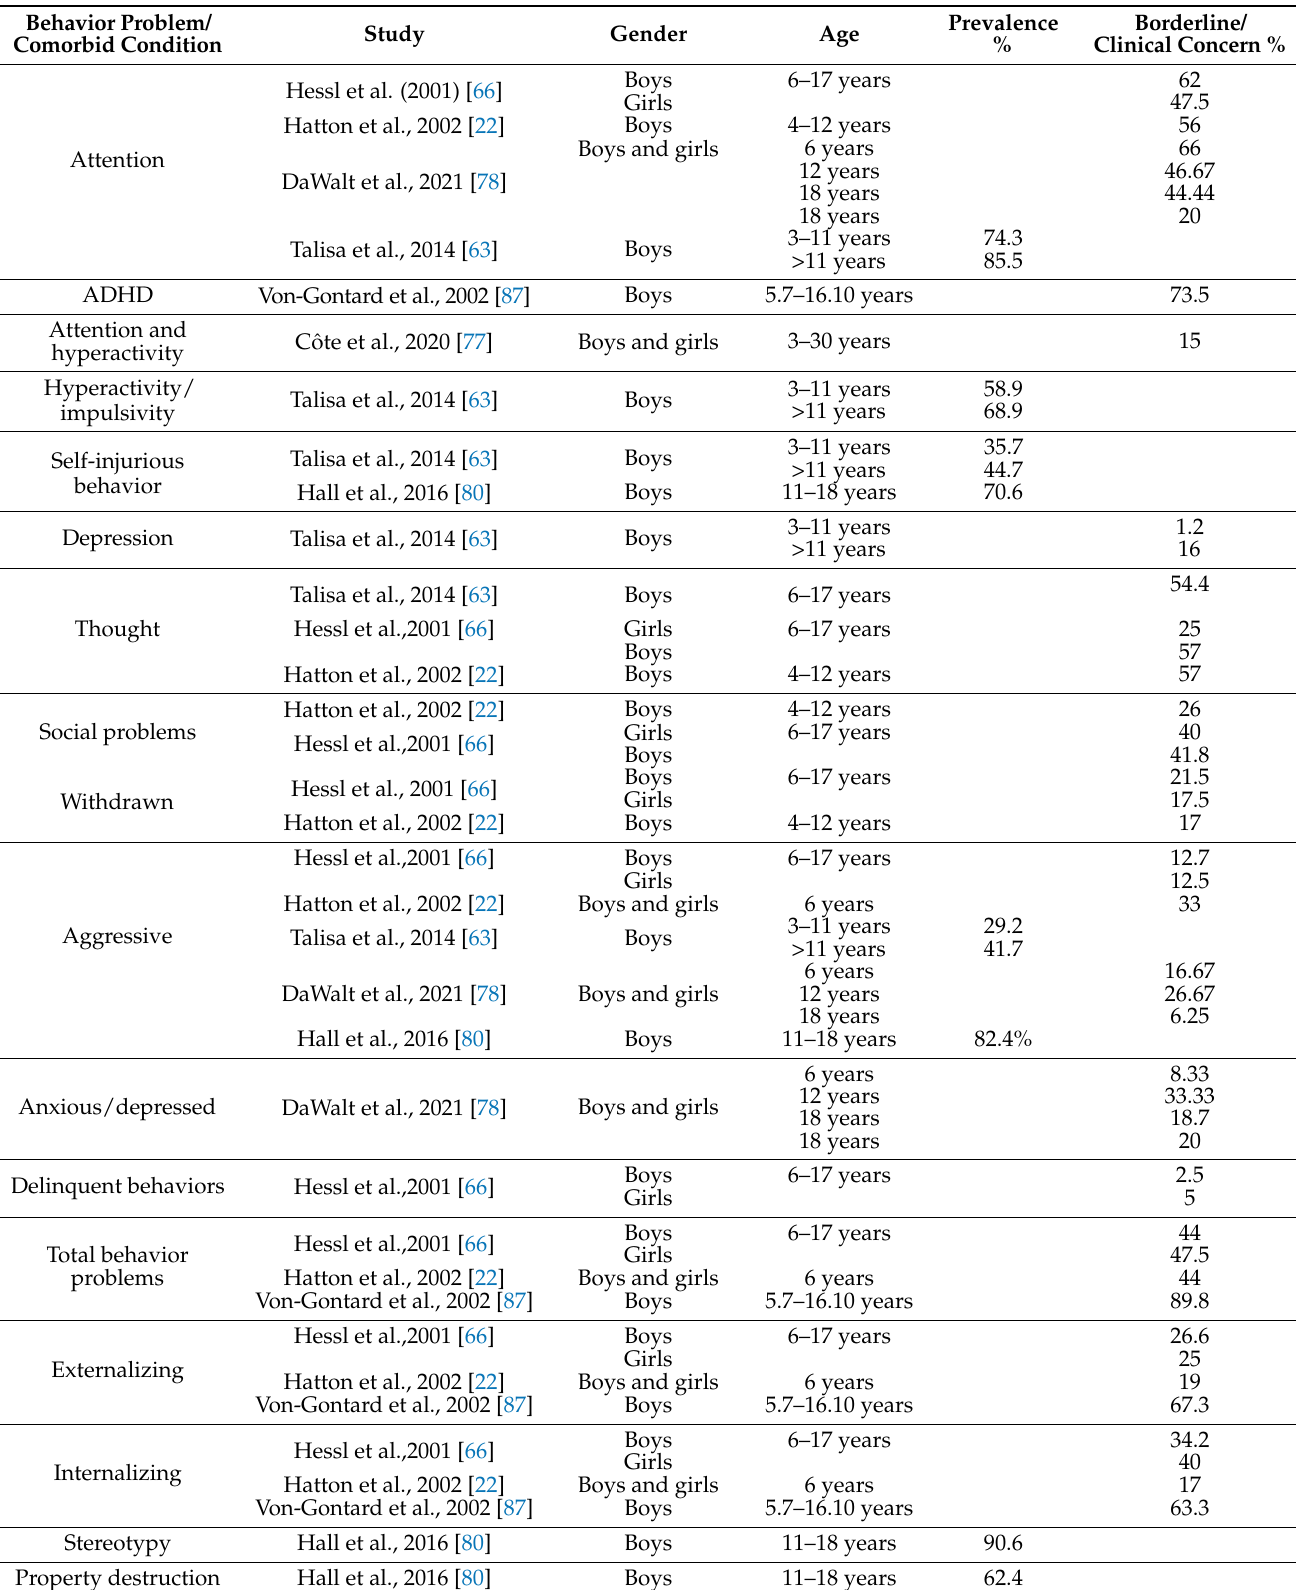
Table A2. Behavior problem and comorbidity prevalence or borderline/clinical concern in the studies